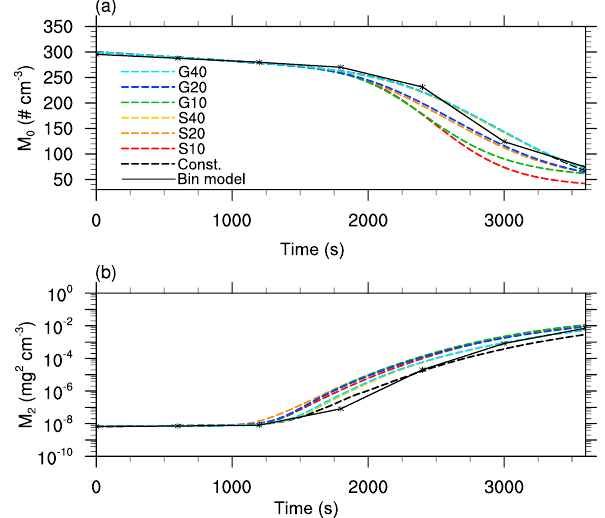
Figure 10. Same as Fig. 6 but for the multi-box approach, i.e., in- teractions between the grid boxes are